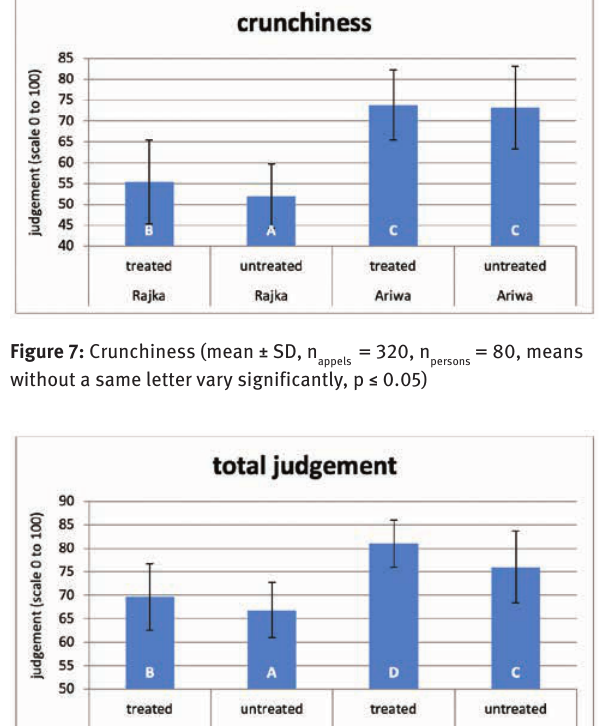
Figure 6: Full flavor (mean ± SD, n without a same letter vary significantly, p ≤ 0.05)